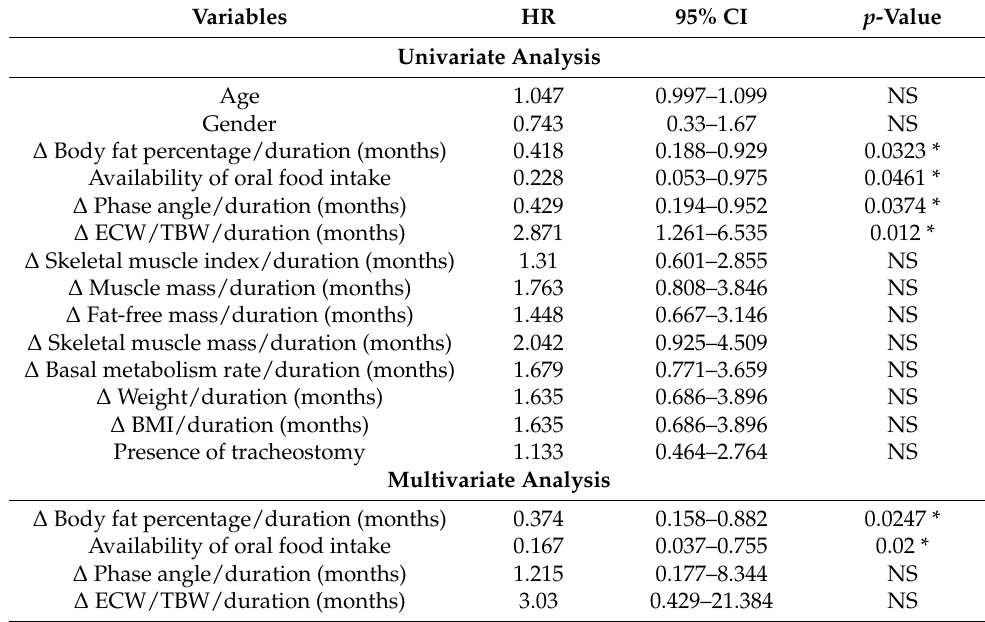
Table 1. Univariate and multivariate hazard proportional regression analyses of variables related to ALS survival.